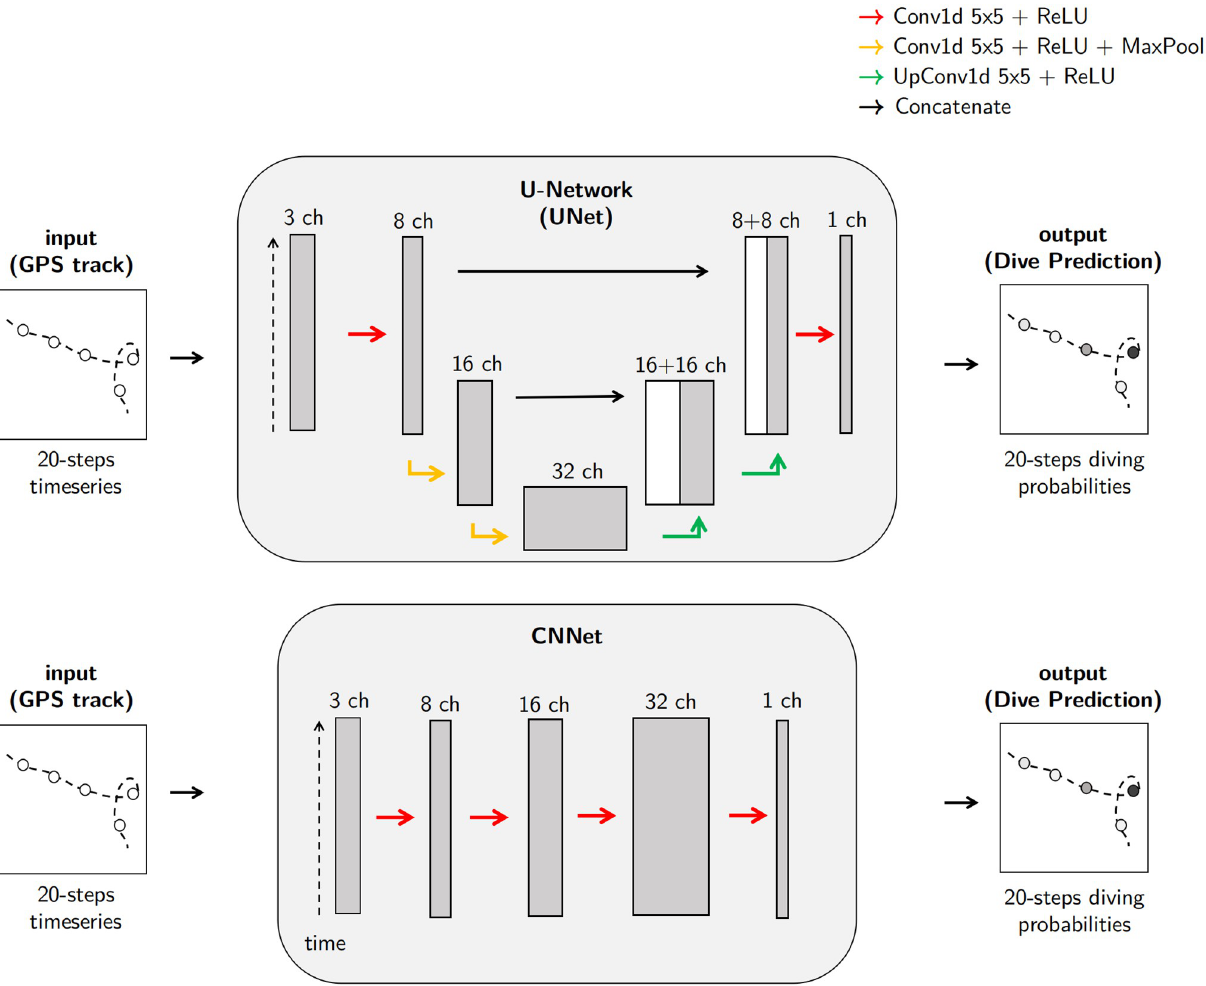
Fig 1. Network architectures. CNNet refers to a fully convolutional neural network. UNet refers to a U-shape network. A channel refer to deep learning terminology and describes a representation of the input data as output of some computation layer. Conv1d, MaxPool, and UpConv1d are abbreviations for usual deep learning operations. Details can be found on pytorch’s documentation